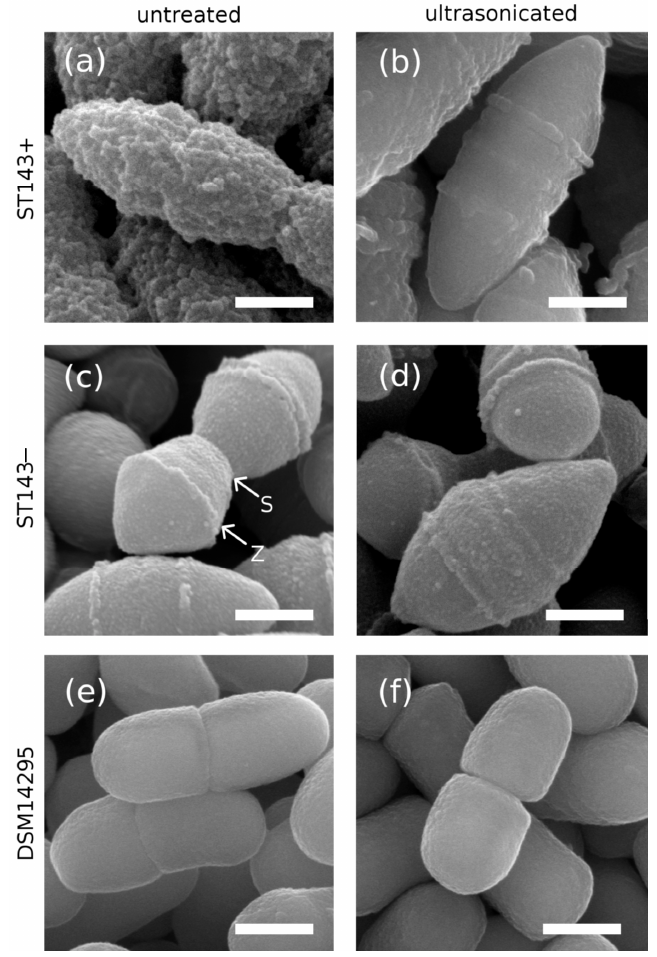
Figure 2. Comparison of the cells of S. thermophilus ST143+ ( a , b ), ST143 − ( c , d ), and W. cibaria DSM14295 ( e , f ) before (left) and after (right) ultrasonic treatment for CPS removal as demonstrated by SEM images. Z: Z-ring; S: septum; scale bar: 500 nm.